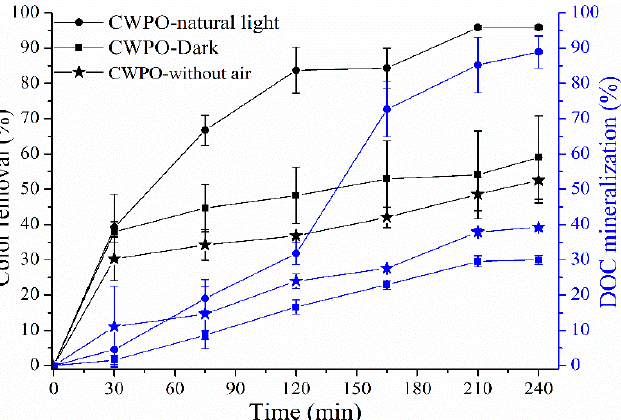
Figure 2. CWPO control experiments in the degradation of NOM: CWPO-natural light (CWPO at optimal conditions with Al/Fe-PILC catalyst under natural light); CWPO-Dark (CWPO under darkness); CWPO-without air (N 2 bubbling and natural lab’s lighting). General conditions: 0.475 dm 3 of NOM solution; [NOM] 0 : 7.0 mg C/dm 3 ; H 2 O 2 dose: 3.77 mg H 2 O 2 /mg DOC; [Al/Fe-PILC]: 3.81 g/dm 3 ; pH: 7.0; T = 18.0 ± 1.0 ◦ C; ambient pressure 72 kPa. Error bars from standard deviations of three replicates.